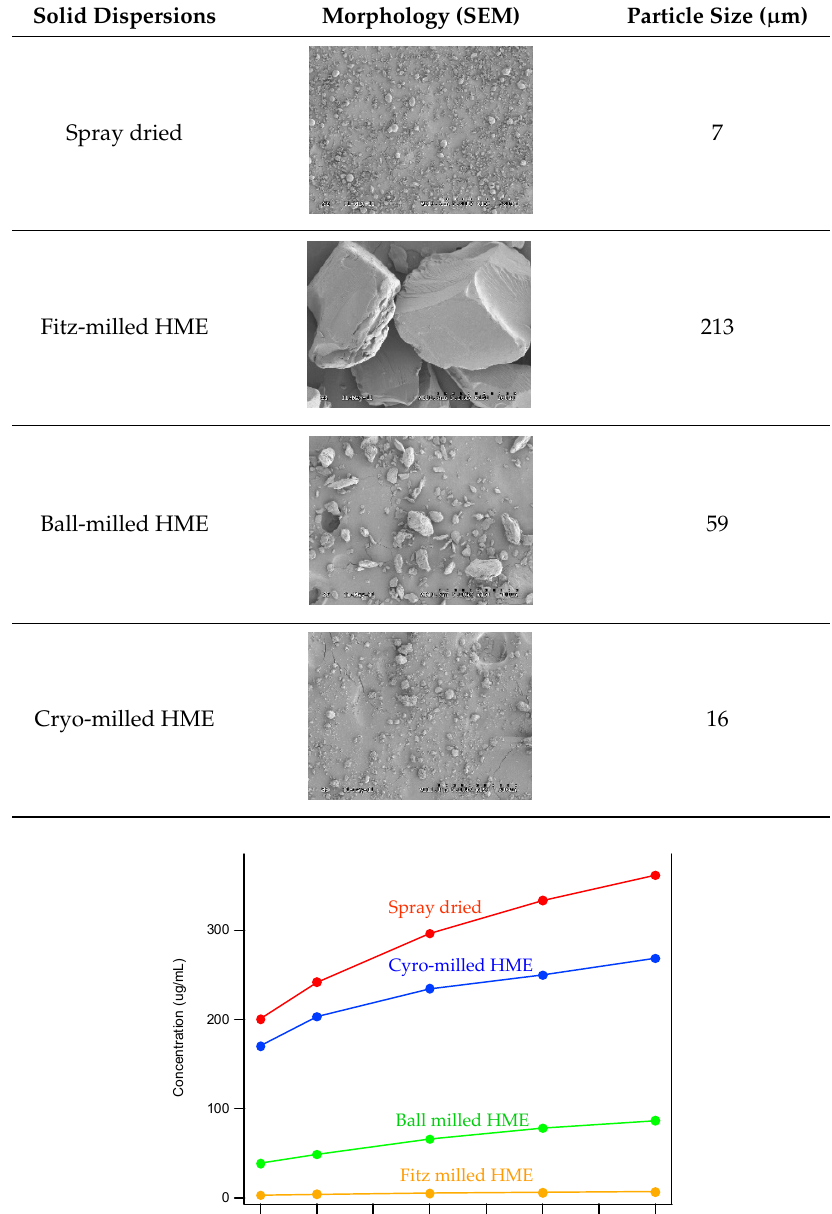
HME and the spray-dried dispersion have particle size in the same range, comparable dissolution profiles were obtained in the SGF stage for both solid dispersions. profiles were obtained in the SGF stage for both solid dispersions. profiles were obtained in the SGF stage for both solid dispersions. profiles were obtained in the SGF stage for both solid dispersions. Table 3. Morphology and particle size of 25% DL HPMCAS-MF solid dispersions at 150 × magnification. Table 3. Morphology and particle size of 25% DL HPMCAS-MF solid dispersions at 150× magnification. Table 3. Morphology and particle size of 25% DL HPMCAS-MF solid dispersions at 150× magnification. Table 3. Morphology and particle size of 25% DL HPMCAS-MF solid dispersions at 150× magnification. Table 3. Morphology and particle size of 25% DL HPMCAS-MF solid dispersions at 150× magnification. Solid Dispersions Solid Dispersions Solid Dispersions Solid Dispersions Solid Dispersions